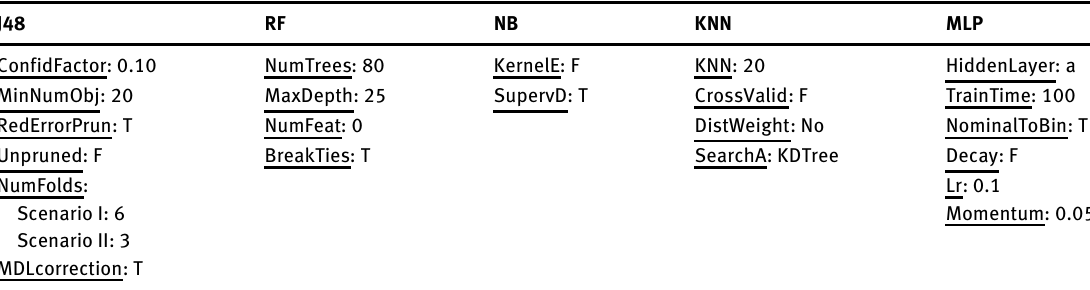
Table 3: Optimized parameters for each data mining technique.